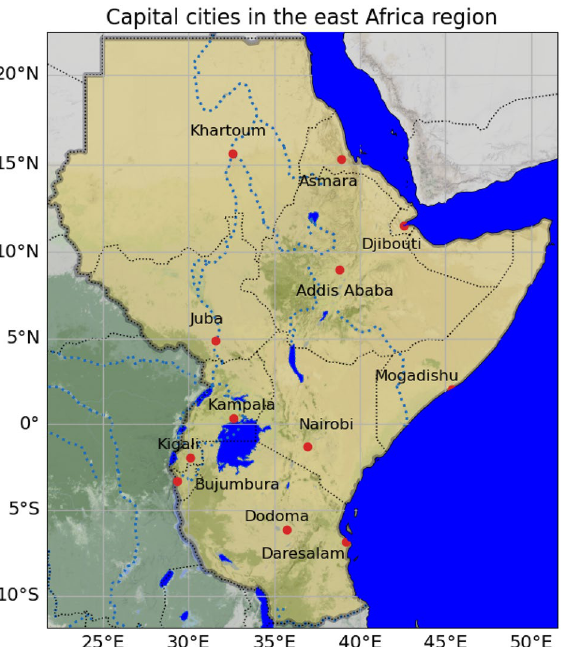
Figure 1. The capital cities in the east Africa region are indicated by the red circles. The region is highlighted with light gold color and all the geophysical features are blue for water and green for terrain